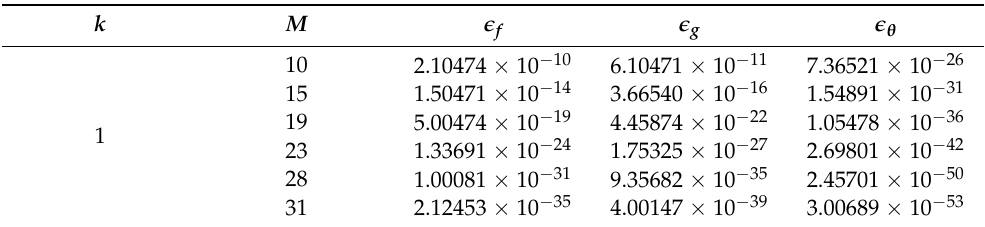
Table 5. Error analysis of axil velocity, tangential velocity and temperature for SWCNTs for different values of M